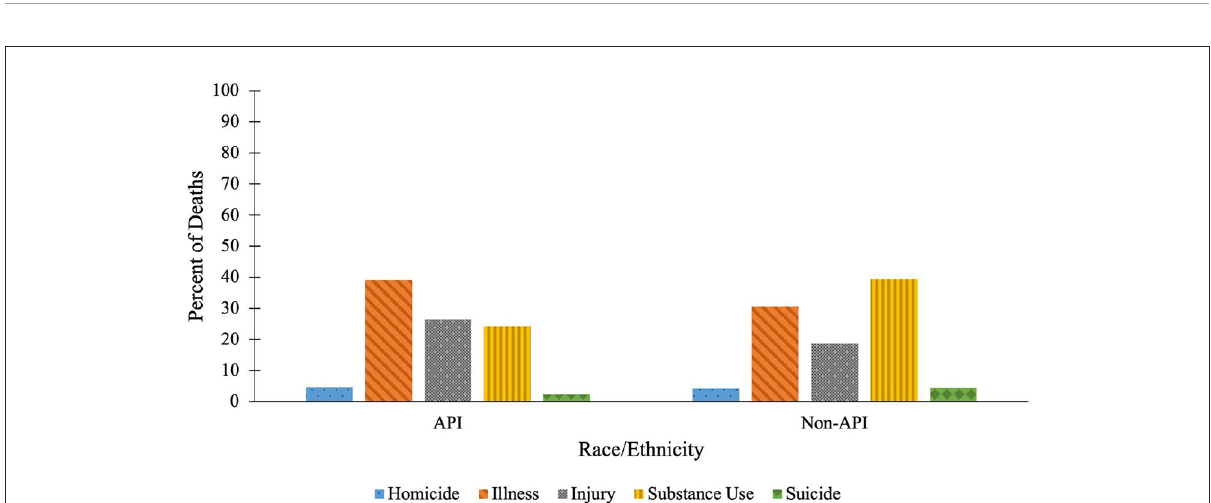
FIGURE1 Distribution of causes of death among APIs vs. all other racial groups. APIs ( n = 87) are compared to all non-API racial groups combined ( n = 1,307).